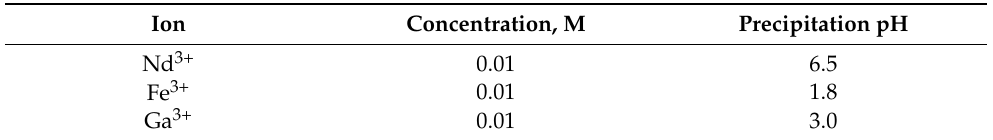
Table 6. The precipitation pH of the metal hydroxides when the concentration of metal ions is 0.01 M [29].